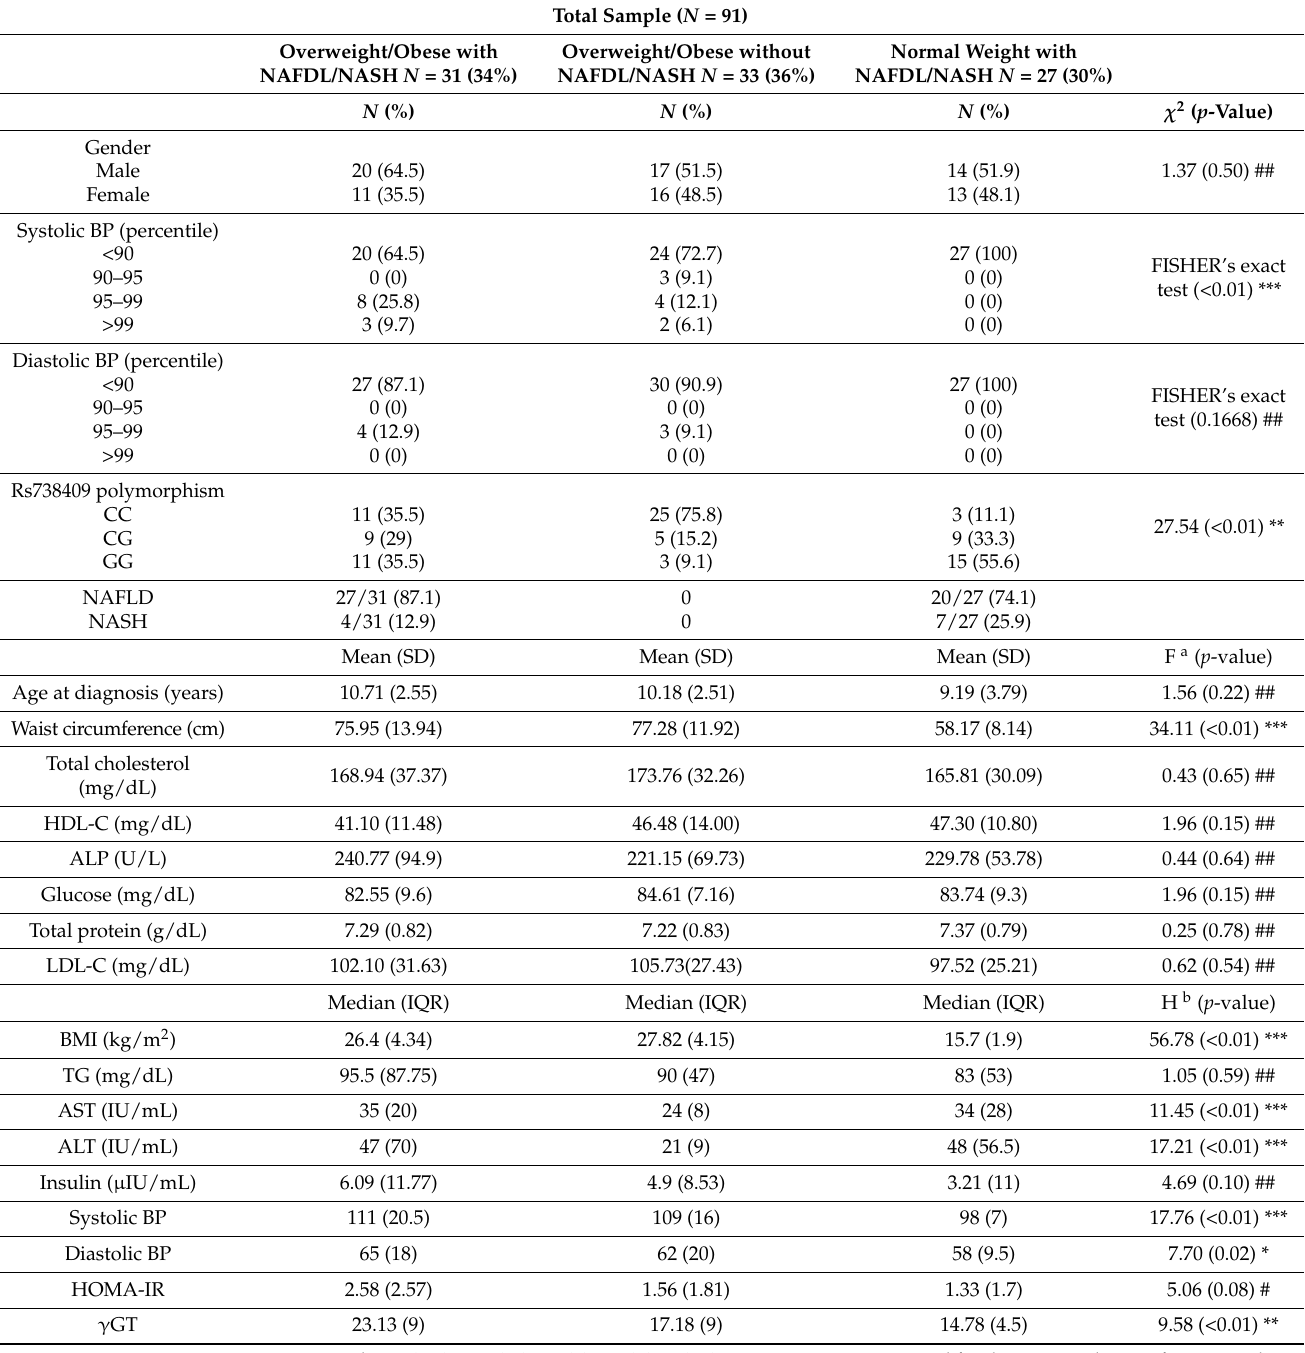
Table 1. Demographic, basic clinical, and laboratory characteristics by group of participants (group 1: overweight/obese with NAFLD or NASH; group 2: overweight/obese without NAFLD/NASH; and group 3: normal-weight children with NAFLD/NASH). Total Sample ( N =